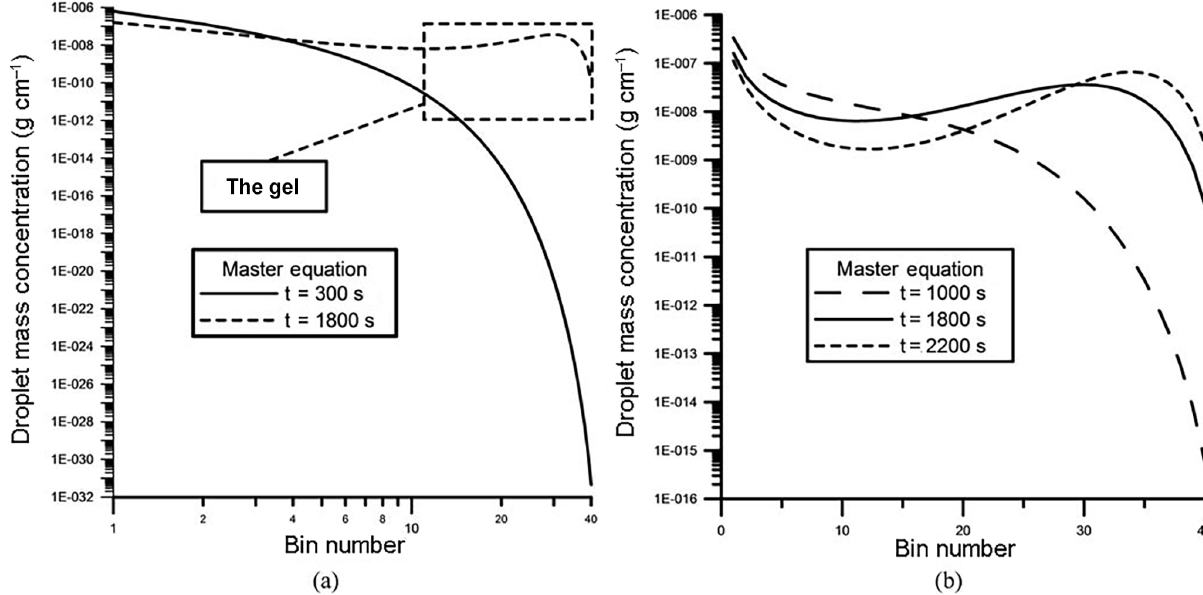
Figure 4. The droplet mass spectrum at different times ( t = 300, 1000, 1800 and 2200s.). The gel is clearly observed at t = 1800, 2200s. Simulations were performed with the collection kernel K(i,j) = Cx i x j (with C = 5 . 49 × 10 10 cm 3 g − 2 s − 1 ) . The initial number of droplets was set equal to N = 40 droplets of 17µm in radius in a volume of 1cm 3